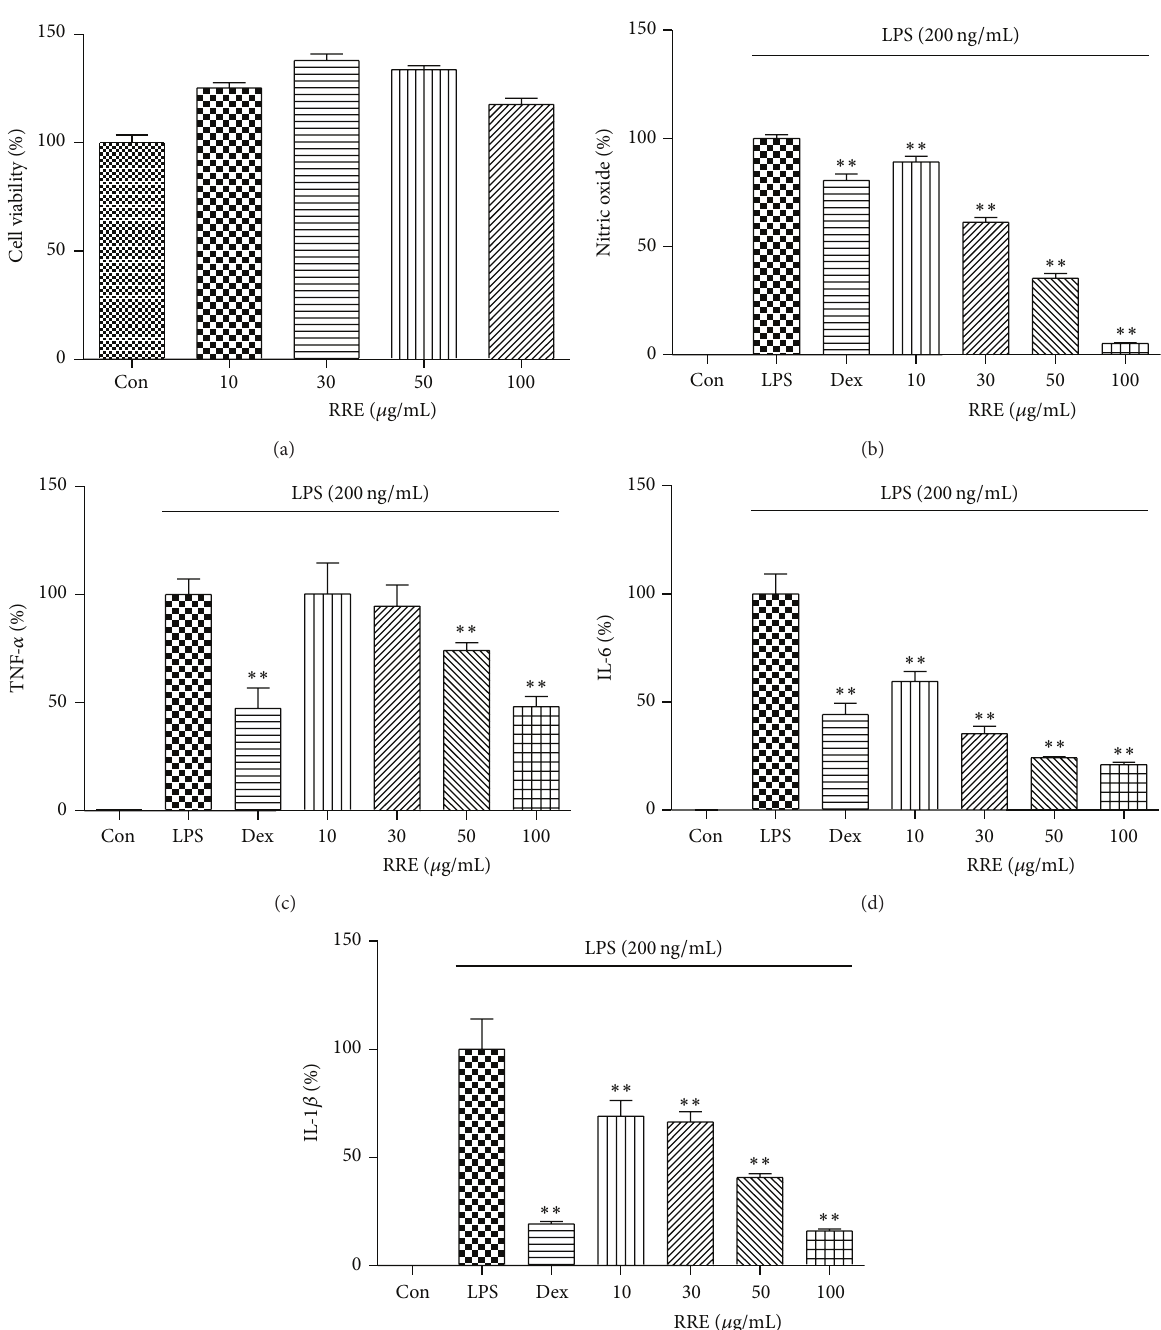
Figure 1: Effects of RRE on (a) cell viability and (b–e) production of inflammatory mediators in RAW 264.7 cells. Cells were pretreated with RRE for 1h prior to 24 h incubation with LPS. (a) Cell viability was measured by CCK assay. (b) NO content in the conditioned media was determined using Griess reagent. Levels of (c) TNF- 𝛼 , (d) IL-6, and (e) IL-1 𝛽 in the media were measured by ELISA. As a control, cells were incubated with vehicle alone. Data represent the mean ± SD of duplicate determinations from three independent experiments. ∗∗ 𝑝 < 0.001 was calculated from comparing with LPS-stimulation